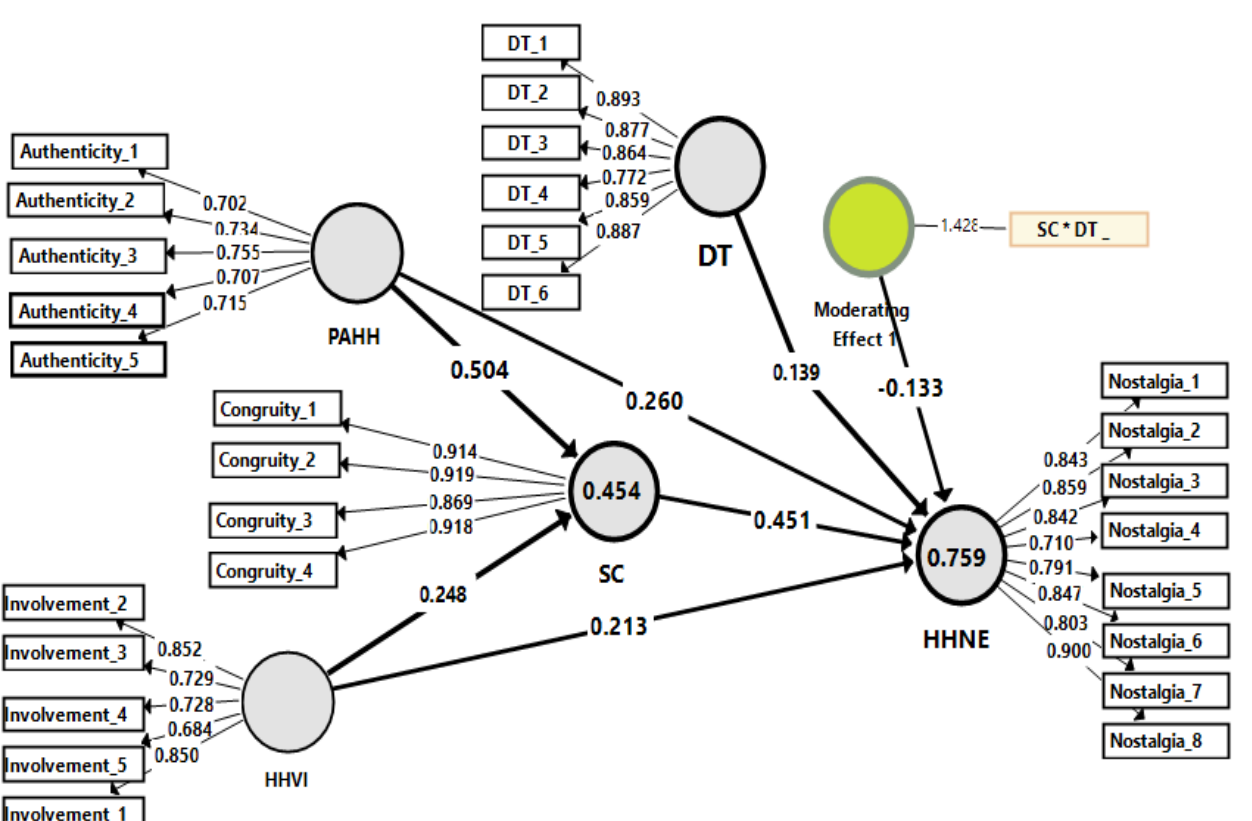
Figure 2. The tested structural and measurement model. R → Perceived Authenticity of Heritage Hotels; HHVI → Heritage Hotel Visitor Involvement; SC → Self-Congruity; DT → Digital Technology; HHNE → Heritage Hotel Nostalgia Experience.